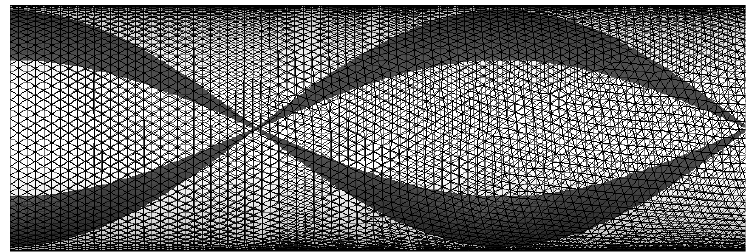
Fig. 4. Tetrahybrid grid of the geometry Fig. 4 Tetrahybrid grid of the geometry